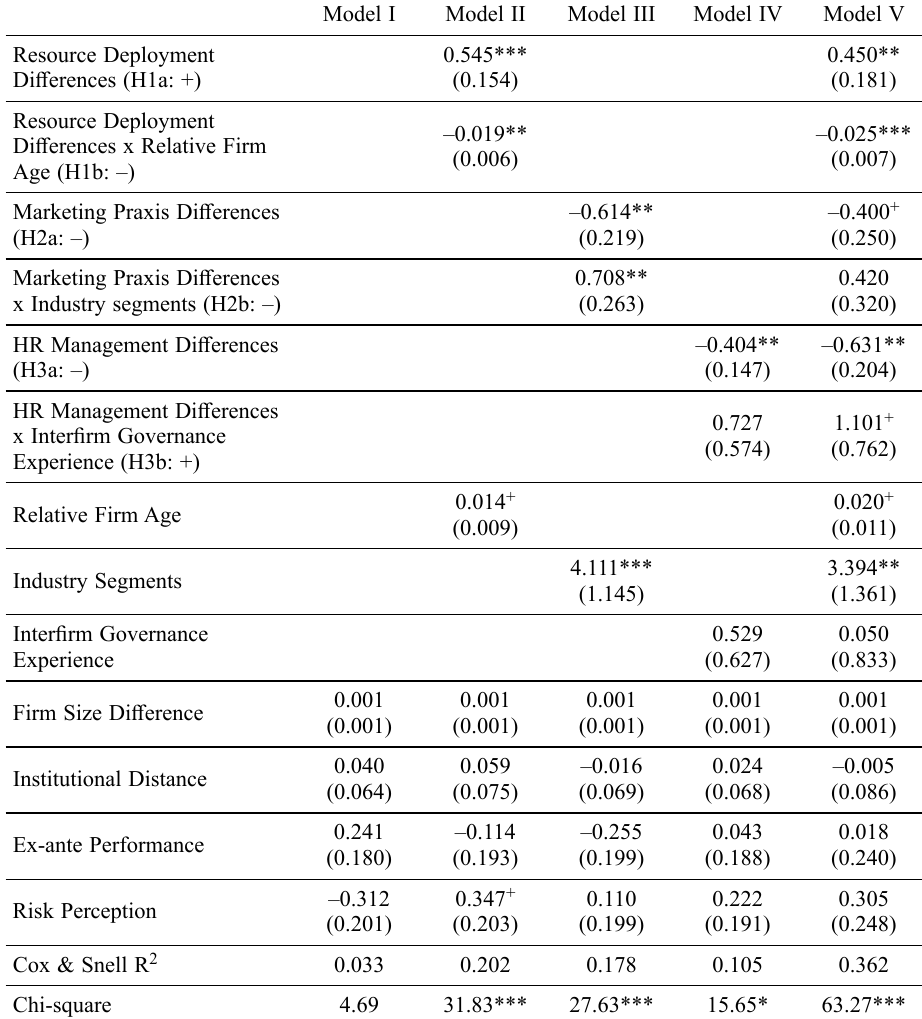
Table 5. Binomial logistic regression results (acquisition = 1and alliance = 0) Model I Model II Model III Model